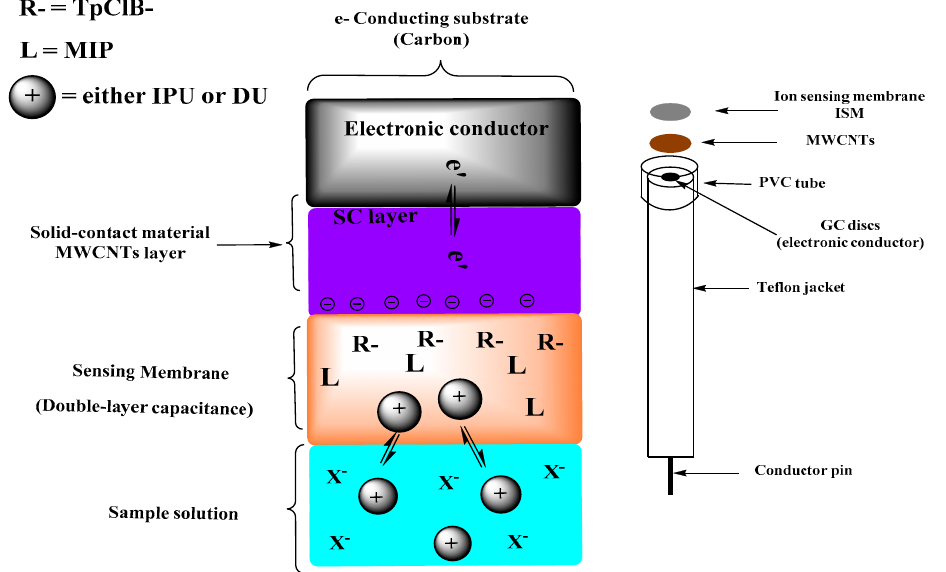
Figure 2. Response mechanism of the proposed solid-contact ion-selective electrodes (ISEs).